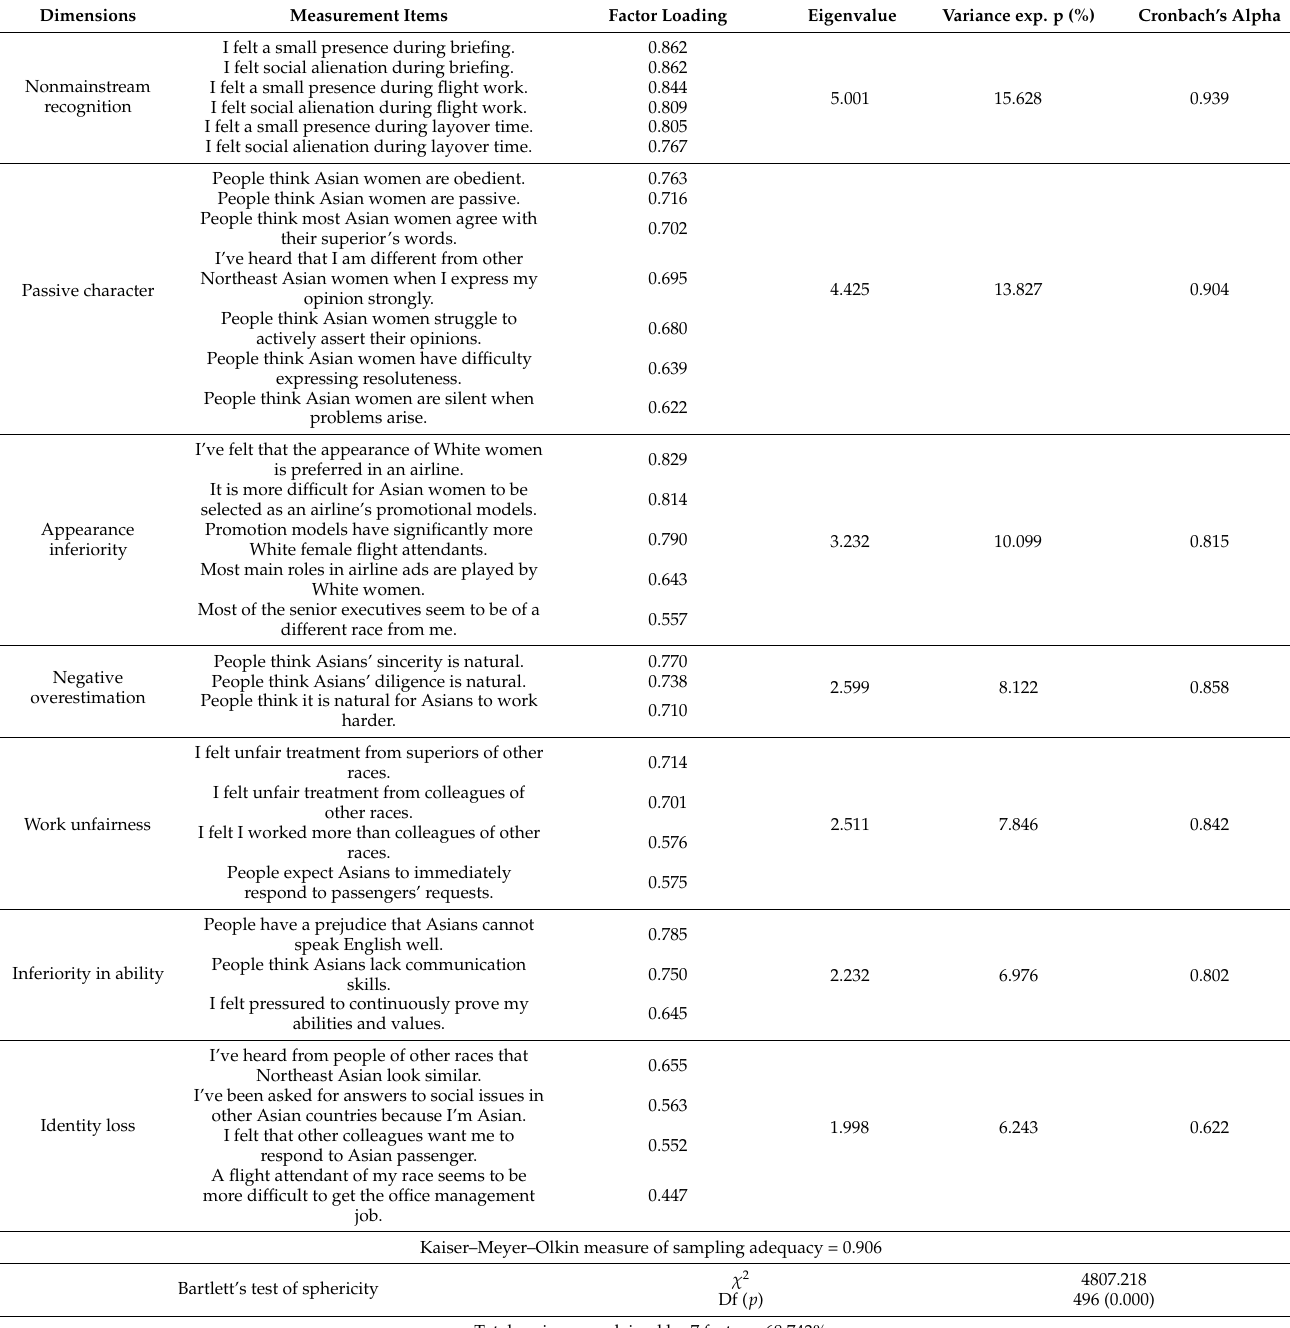
Table 5. Exploratory factor analysis and reliability analysis